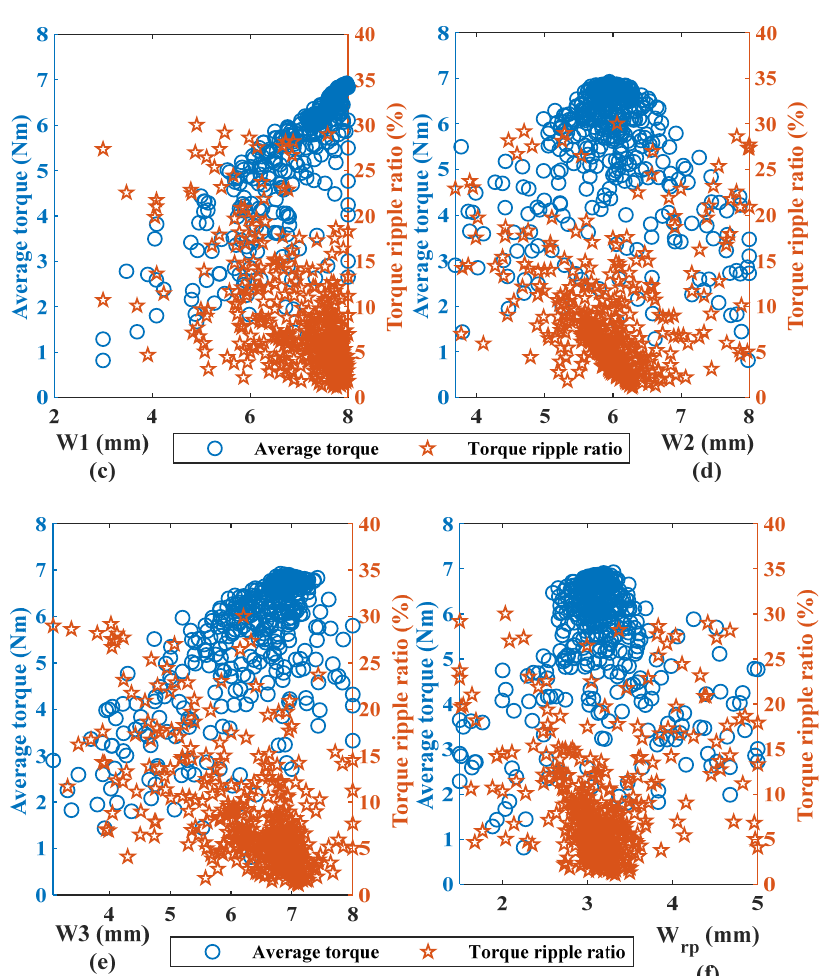
Figure 9. Torque and ripples ratio w.r.t optimization parameters ( a ) R1 ( b ) W ry ( c ) W1 ( d ) W2 ( e ) W3 ( f ) W r .